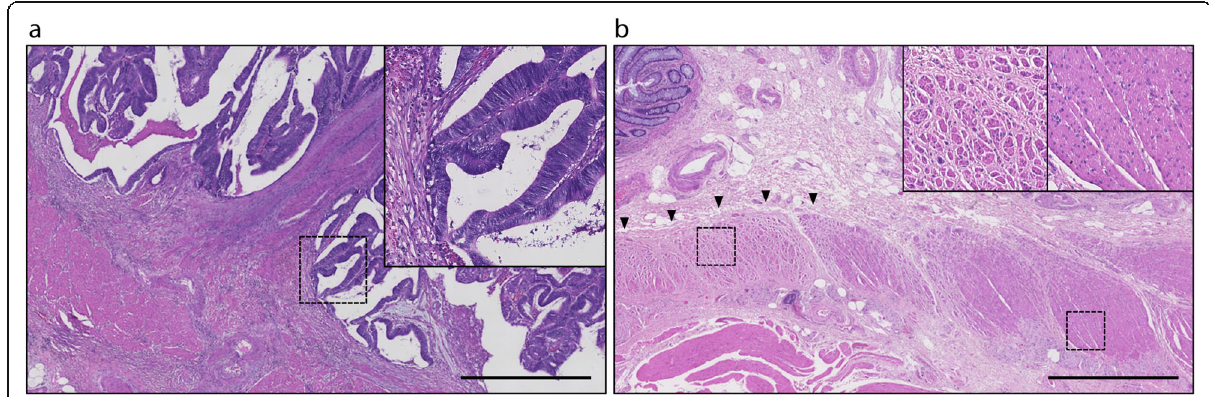
Fig. 5. Hematoxylin and eosin staining of the specimen. Scale bar, 1 mm. a ) Pathological examination of the tumor revealed well-differentiated tubular adenocarcinoma invading into muscularis propria layer. b ) Histological examination of the distal stump showed significant fibrosis of the muscularis propria layer (black arrowheads and left small window) compared to the normal one (right small